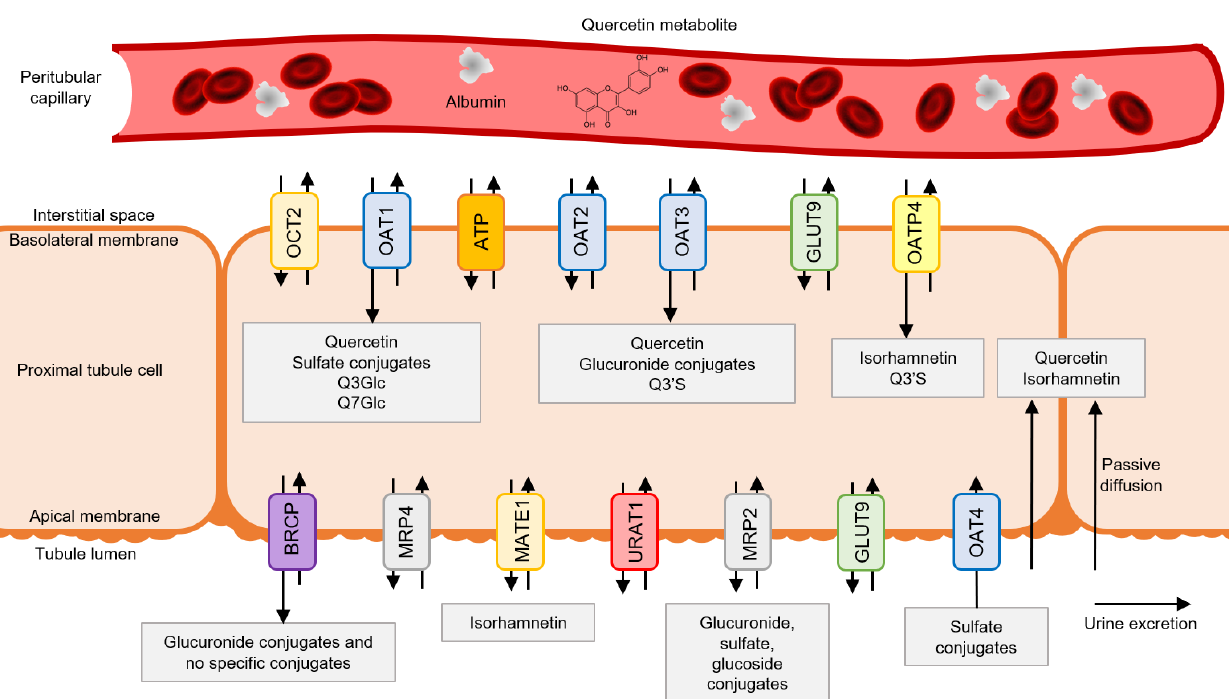
Figure 2. Quercetin transporters and their metabolites in proximal tubular cells. In summary, quercetin metabolites enter the tubular cell through passive diffusion of the influx transporters OAT1, OAT3, and OATP4 via tubular secretion and transporter OAT4 via reabsorption. The efflux transporters BCRP, MRP2, and MATE1 cause effective elimination of quercetin metabolites for urine